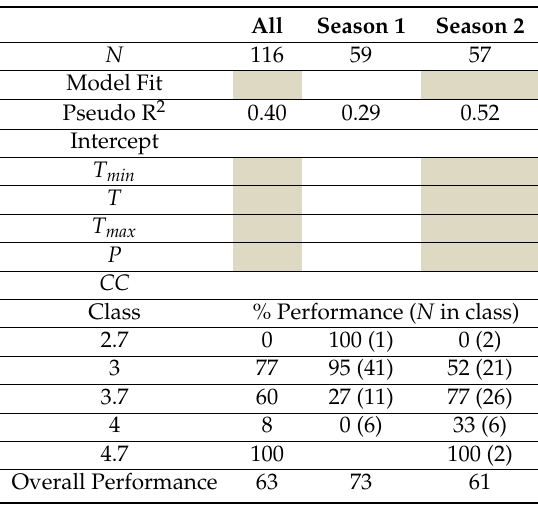
Table 6. MLR modelling results for Log FC y,m . A shaded box indicates a significant relationship and no shading indicates the p -value was greater than